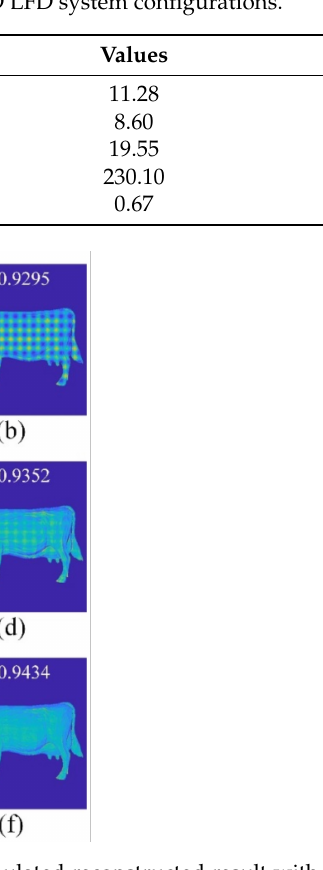
Figure 10. Simulation results comparison: ( a ) simulated reconstructed result with the conventional spread function at the optimal diffusion angle; ( b ) SSIM corresponding to the reconstructed result in ( a ); ( c ) simulated reconstruction result with the conventional spread function at the highest value of SSIM; ( d ) SSIM corresponding to the reconstructed result in ( c ); ( e ) simulated reconstruction result with the proposed spread function at the optimal diffusion angle (also the highest value of SSIM); and ( f ) SSIM corresponding to the reconstructed result in ( e